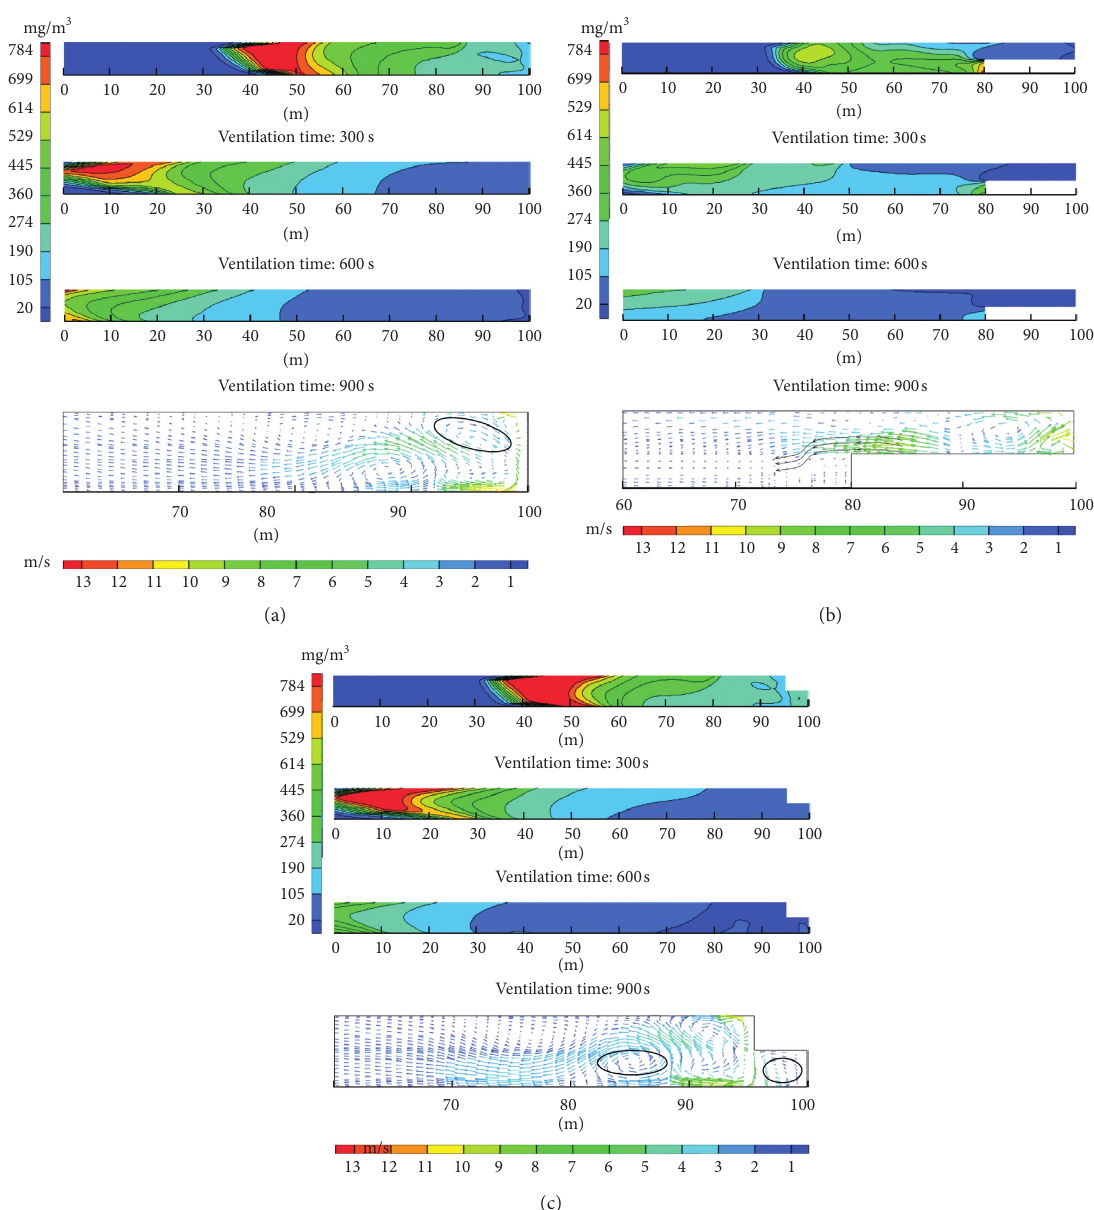
Figure 11: CO ventilation diffusion concentration change in the tunnel after blasting cloud map and working face speed vector. (a) Full- section construction. (b) Step construction. (c) Advance construction of lower guide